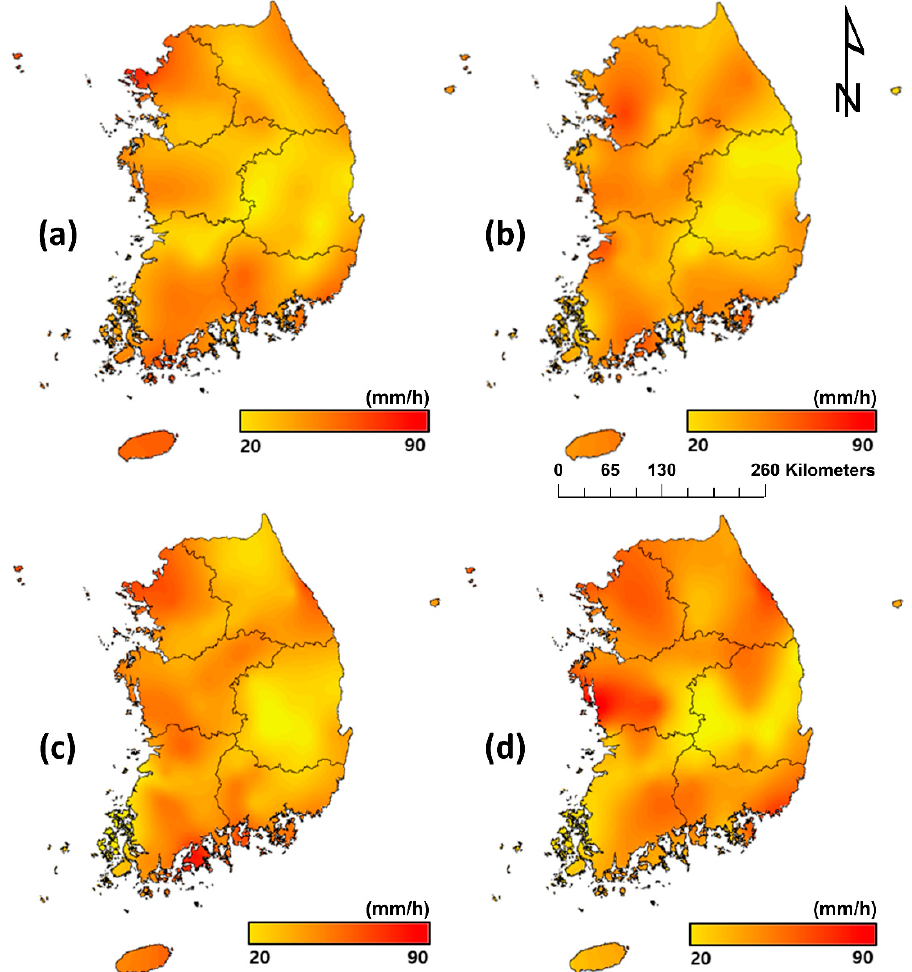
Figure 5. Design rainfall intensity for which RCM was applied (duration 3 h and return period 30 years). These figures show the spatial distribution of the design rainfall intensity estimated ( a ) from ML-MM5-RCP 8.5 (2021–2050), ( b ) from ML-WRF-RCP 8.5 (2021–2050), ( c ) from ML-RegCM4-RCP 8.5 (2021–2050), and ( d ) from ML-RSM-RCP 8.5 (2021–2050).